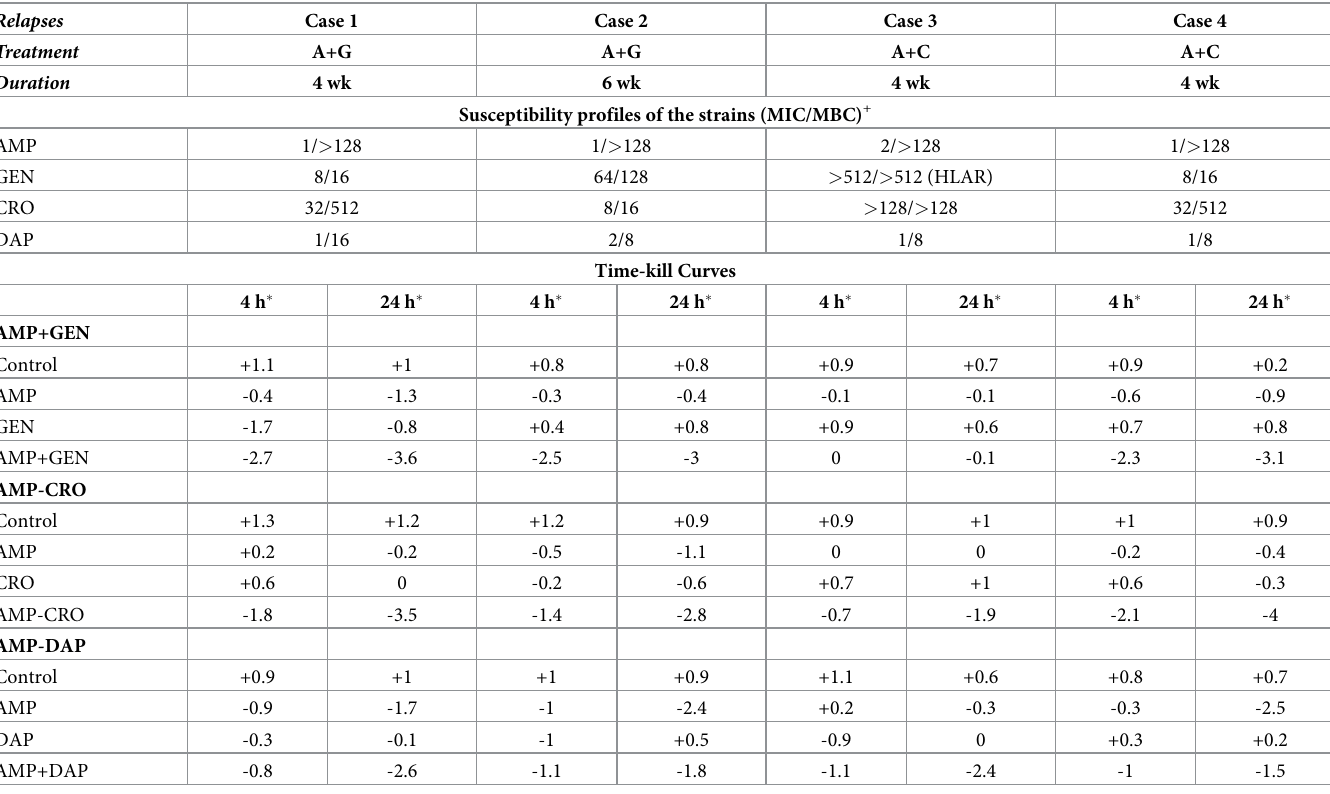
Table 3. Susceptibility patterns and time-kill curves with ampicillin plus gentamicin, ceftriaxone, or daptomycin against the strains causing the 4 relapses.